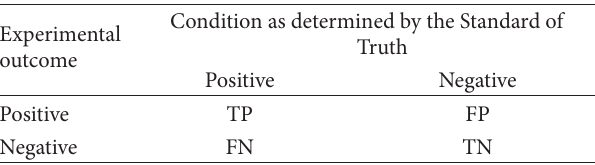
Figure 4: Scaling function and wavelet function for Coiflet 5. Table 2: Definition of the terms.